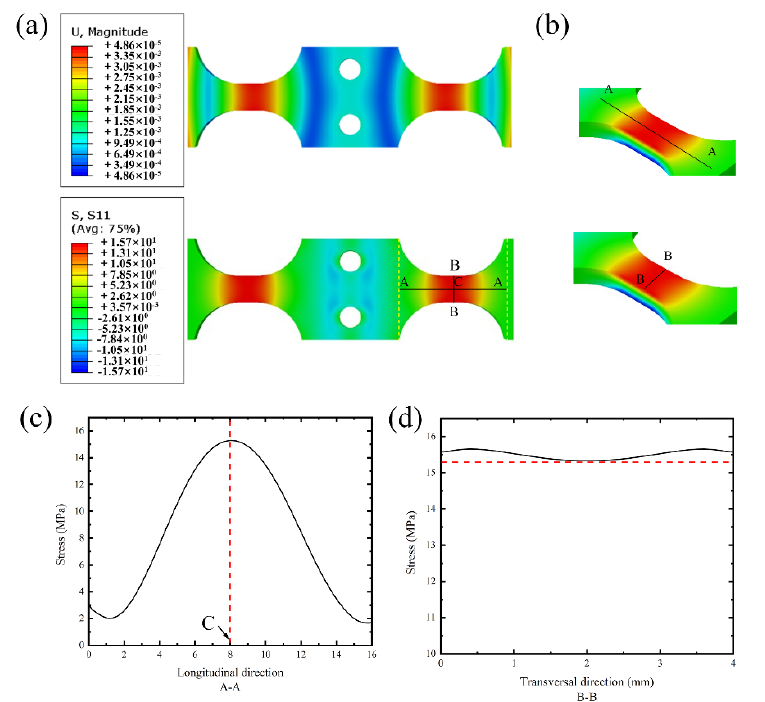
Figure 3. The stress distribution on the bent specimen: ( a ) finite element analysis (FEA) solved dis-tribution of displacement and stress; ( b ) paths of stress collecting at the gauge section; ( c ) stress profile along the longitudinal direction; ( d ) stress profile along the transversal direction.